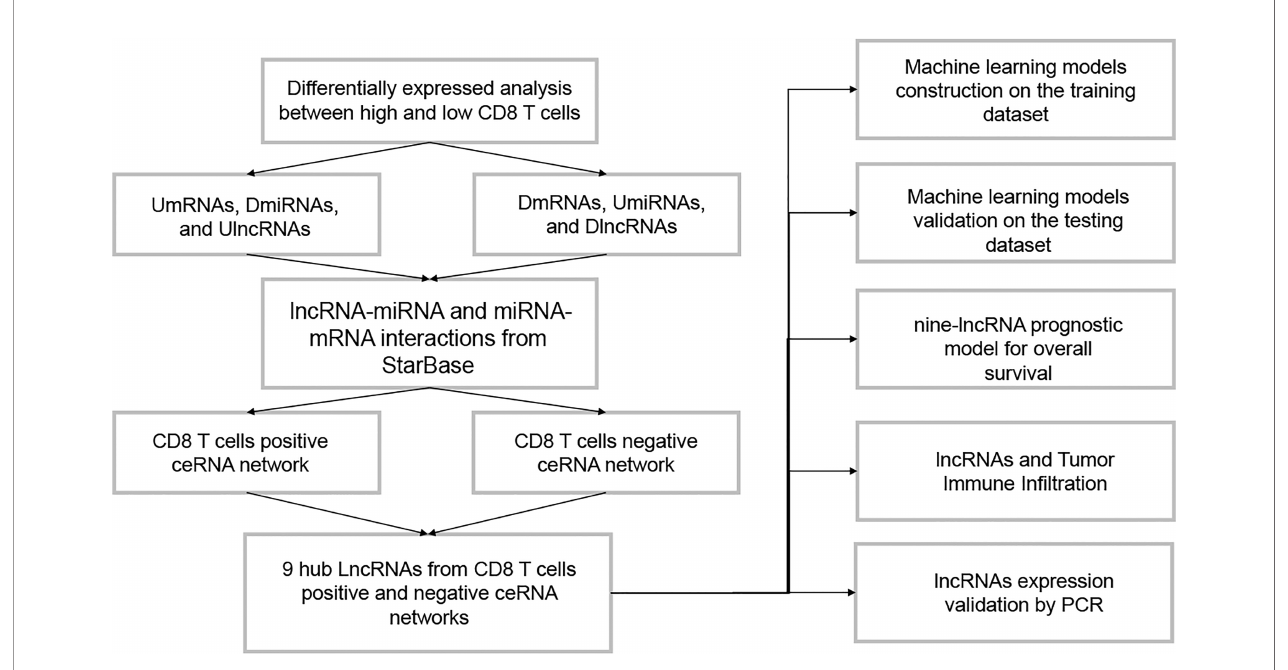
FIGURE 1 | The fl owchart of this